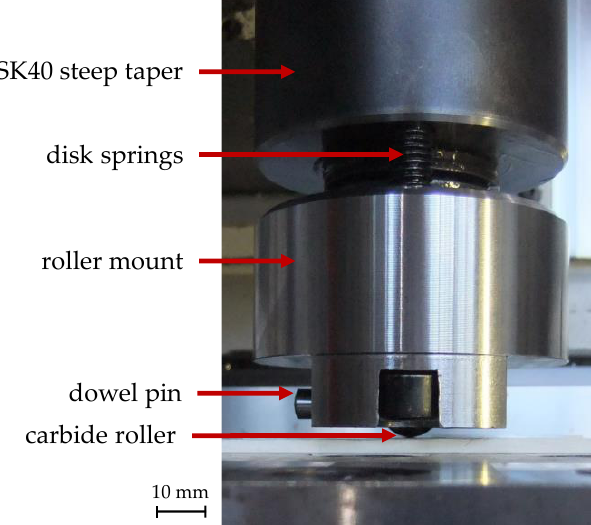
Figure 3. Assembled deep rolling tool.